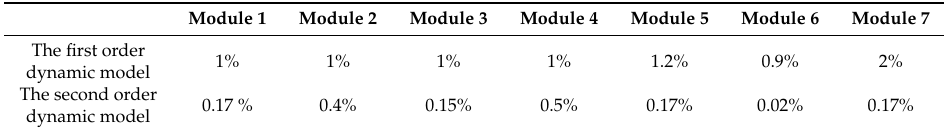
Table A3. The comparison of SoC estimation error of cell modules for two cases: the first and second order dynamic models of the cell at 25 ◦